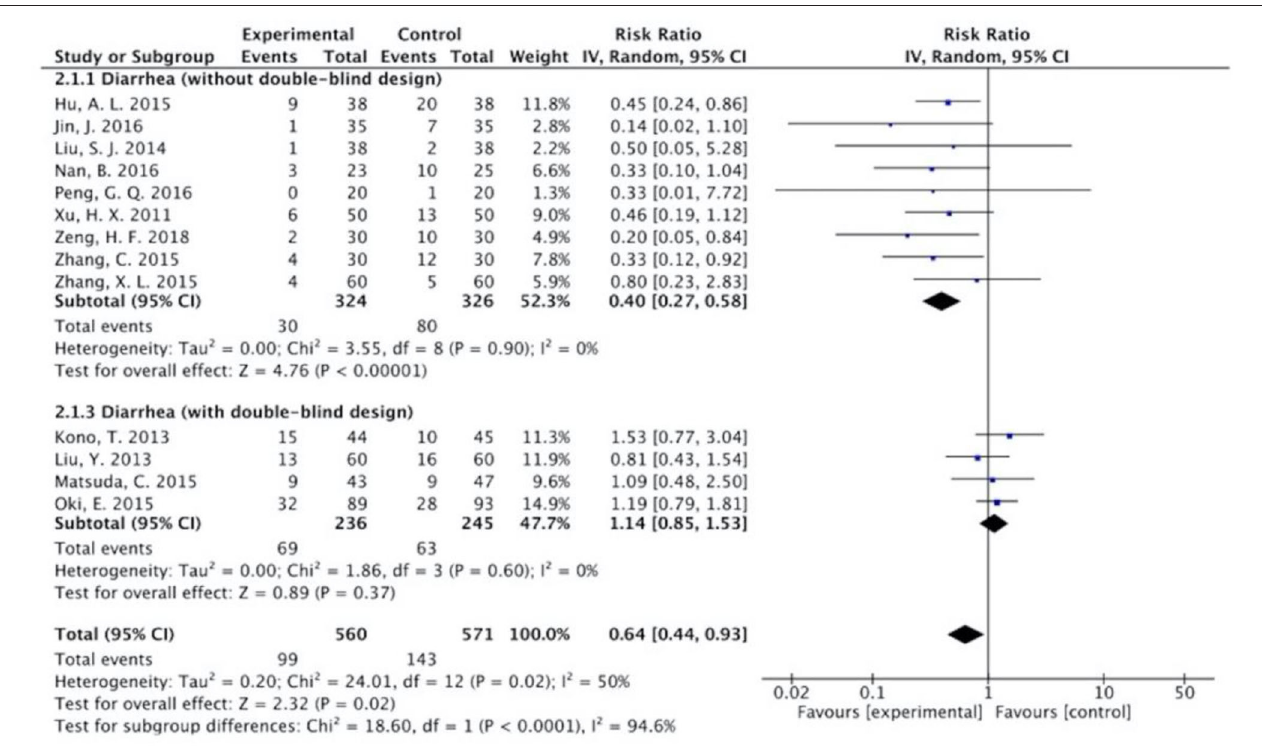
FIGURE 8 | Sub-analysis on the effect of herbal medicine in diarrhea in chemotherapy-induced toxicity.